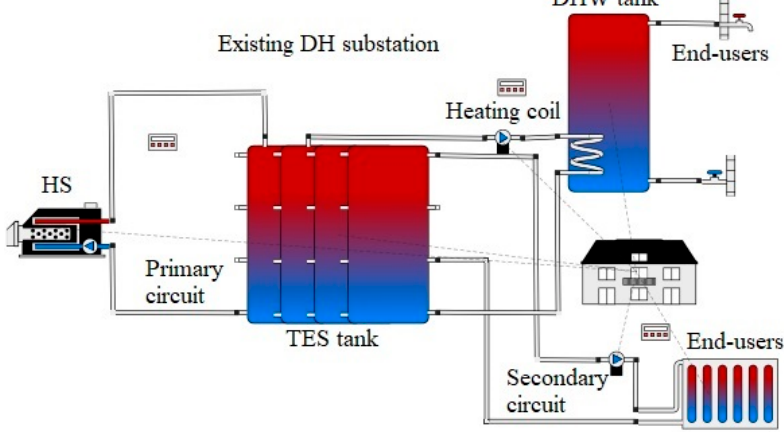
Figure 11. Schematic diagram of existing “UMT” district heating (DH) substation.